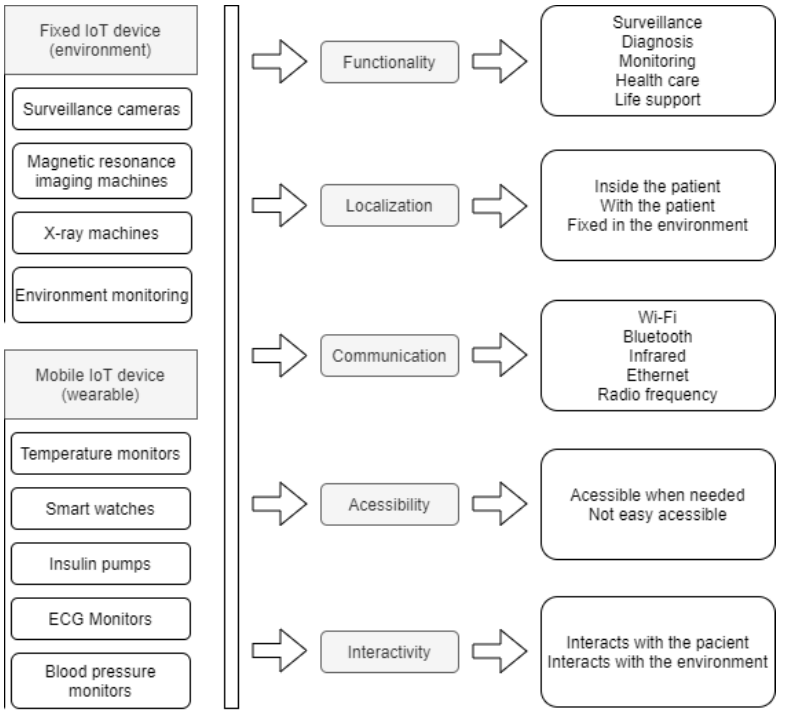
Figure 2. Devices with its